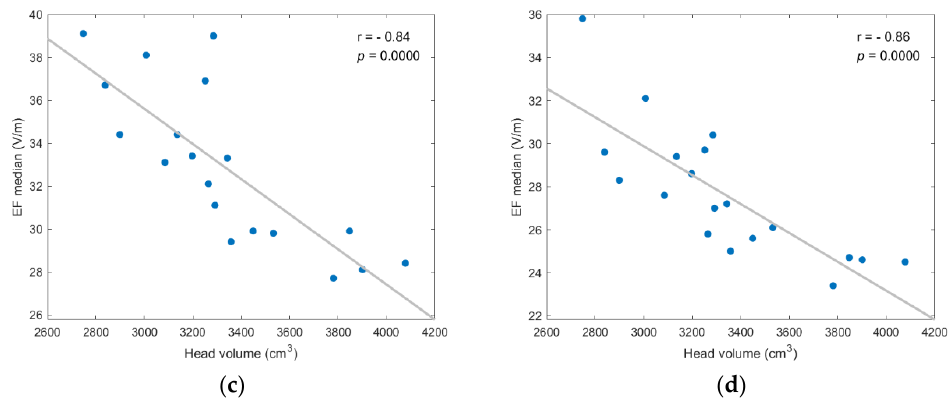
Figure 6. EF median showed strong, and statistically significant negative, correlation to head volume for each investigated scenario; ( a ) frontal coil position on anatomical models; ( b ) frontal coil position on homogeneous models; ( c ) central coil position on anatomical models; ( d ) central coil position on homogeneous models. Figure 7 provides evidence that stimulated volume might be associated with age, with Spearman correlation coefficient values ranging from −0 .55 to −0 .75 and correspond- ing p -values < 0.02 (df = 17). However, despite that the correlation with age was statisti- cally significant between the actual size of stimulated volume (in cm 3 ), the normalized stimulated volume test with age resulted in lower correlation coefficients, ranging from −0 .38 to −0 .62, and less significant p -values ranging from 0.04 to 0.11. Normalized stimu- lated volumes were calculated as the ratio of stimulated volume over the total brain or head volume.